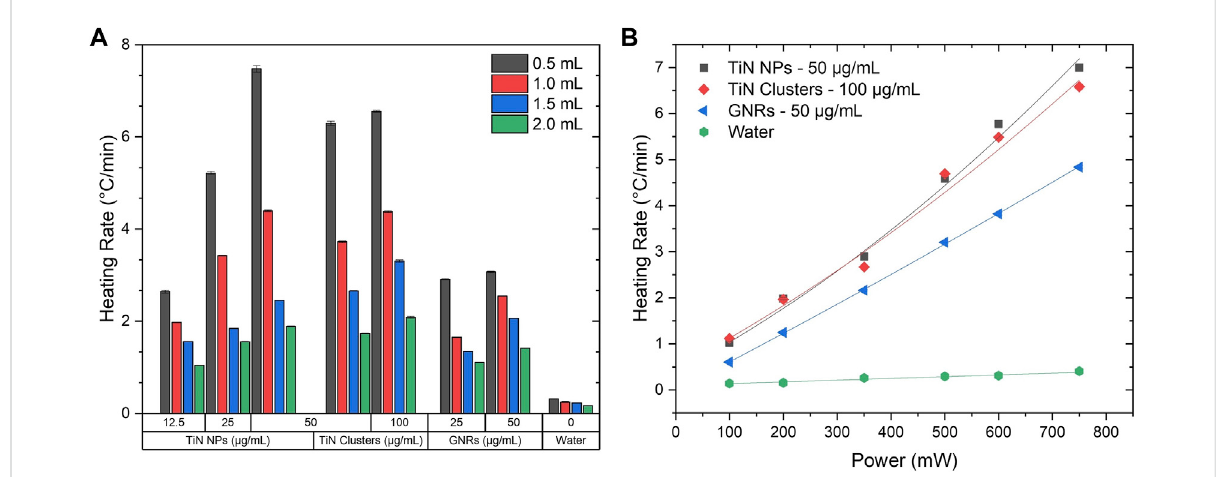
FIGURE 4 Heating rate maps. (A) Heating rate as a function of volume at a maximum laser power of 750 mW using the 4LB setup for various concentrationsofTiNNPs,TiNclusters,andGNRs. (B) Heatingrateasafunctionofpowerat500 μ Lusingthe4LBsetupforTiNNPs(50 μ g/mL),TiN clusters (100 μ g/mL), and GNRs (50 μ